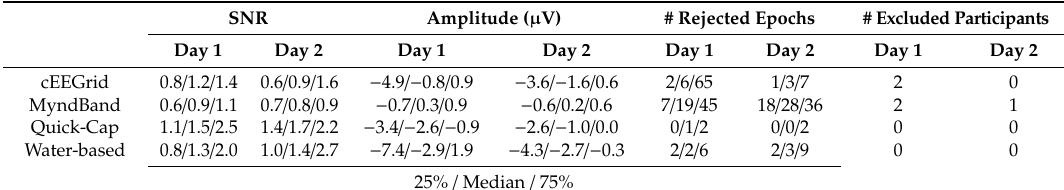
Table 1. Results of the signal quality analyses for the four headsets. The signal-to-noise ratio (SNR), average amplitude around the movement onset, number of rejected epochs, and number of rejected participants are presented for both experimental sessions. The results are presented based on Cz (water-based electrodes and Quick-Cap) or the channel closest to that (MyndBand and cEEGrid). SNR Amplitude ( µ V) # Rejected